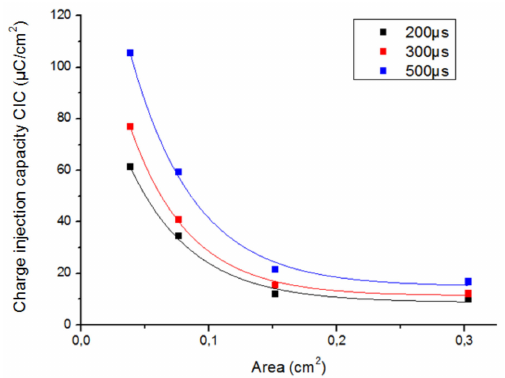
Figure 7. CIC of the foil Pt square electrodes A as a function of the electrode area for three di ff erent pulse widths of the stimulation signal.